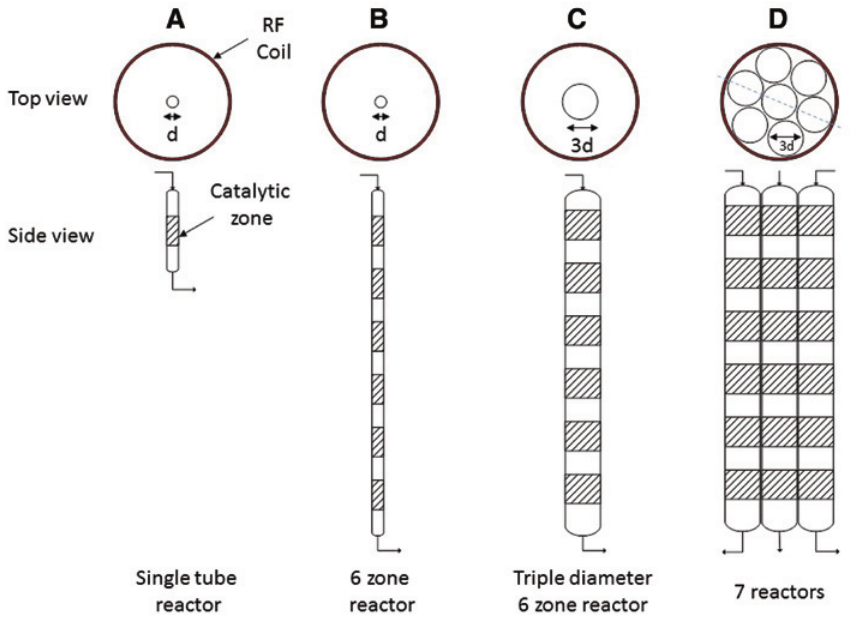
Figure 7: Schematic representation of the scale-up methodology. (A) Laboratory scale micro trickle bed reactor, (B) axial scale-up, (C) radial scale-up, (D) scale-up by numbering up.